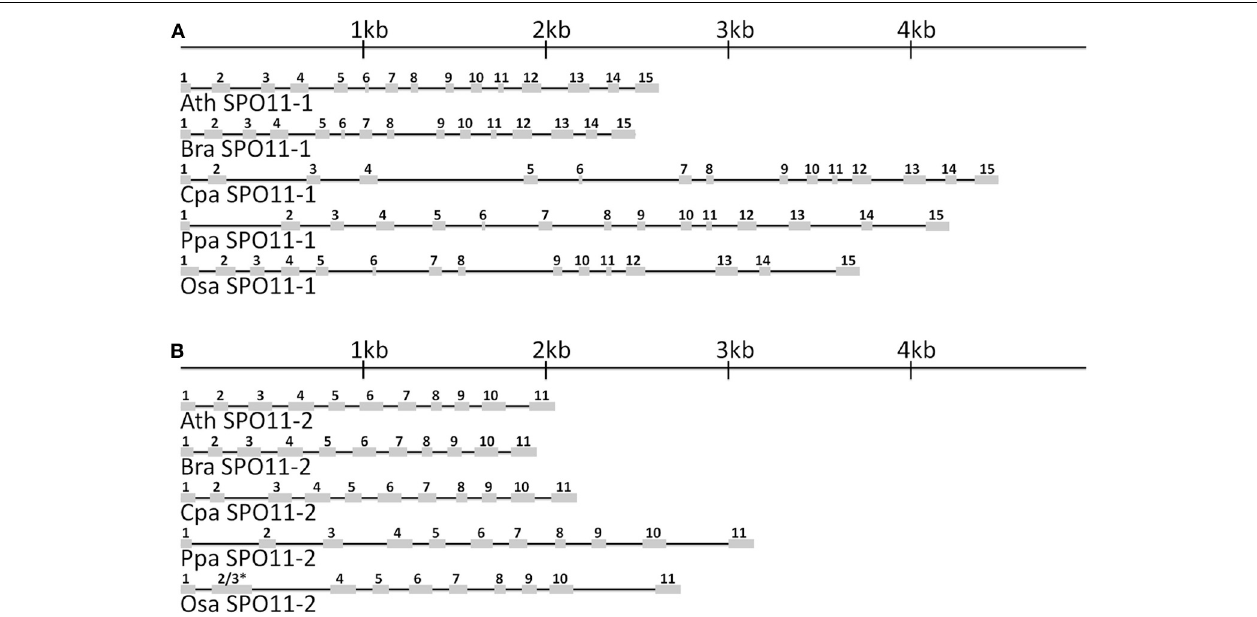
sativa . Coding regions are represented by gray boxes. The introns are represented by black lines. ∗ Intron 2 has been lost in OsaSPO11-2. For a better comparison exon 2 was marked with 2 and 3 due to their fusion.